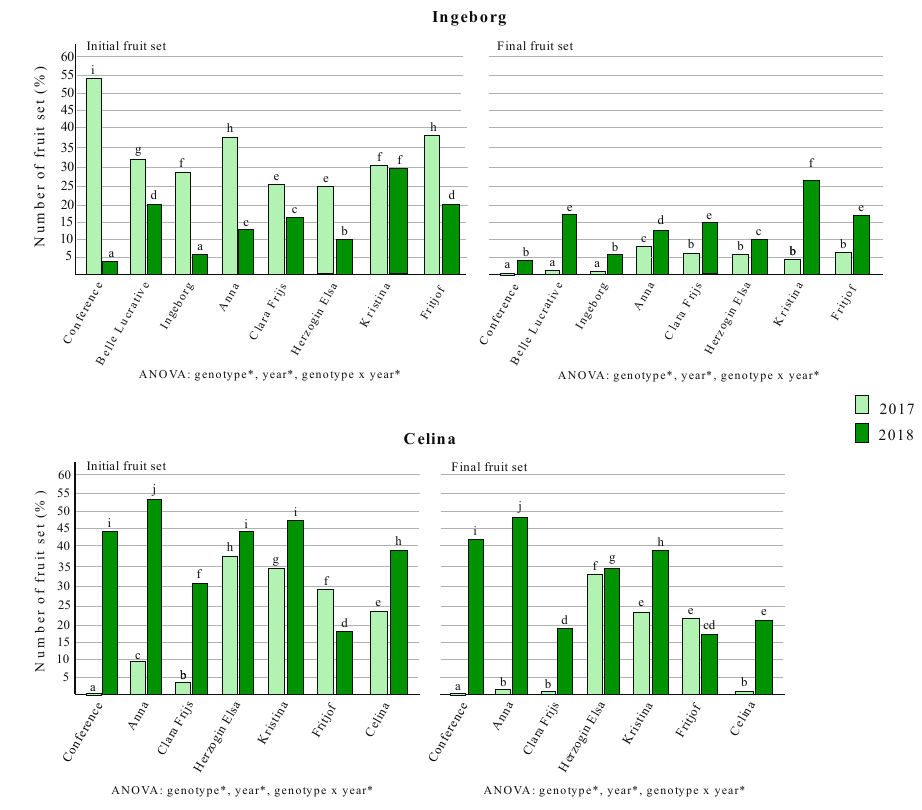
Figure 9. Fruit set of cultivars “Ingeborg” and “Celina” in different combinations of pollination in 2017 and 2018 (different letters above the bars denotes a significant difference between clones according to the LSD test, p < 0.05).